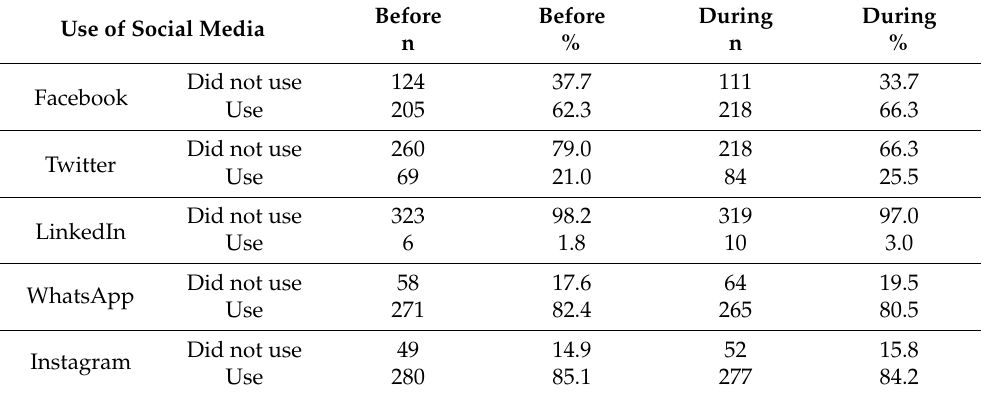
Table 5. Type of social media used before and during confinement COVID-19 by the study participants.